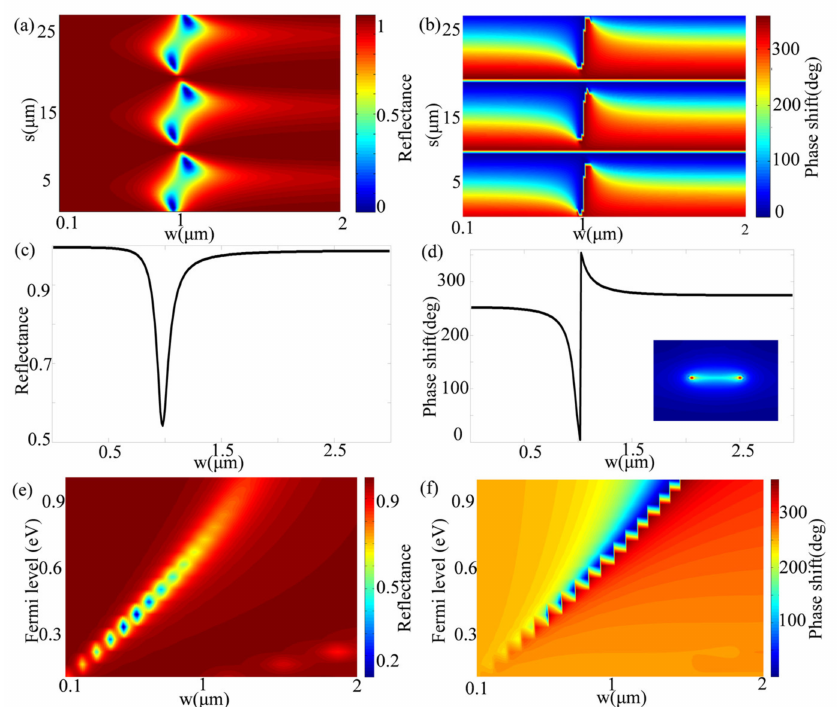
Figure 2. ( a ) Reflectivity and ( b ) phase shift is the function of the graphene ribbon width ( w ) and the dielectric layer thickness (s). ( c ) Reflectivity and ( d ) phase shift vary as the graphene ribbon width ( w ) increasing at a thickness of the dielectric layer (s) as 3 µ m. ( e ) Reflectivity and ( f ) phase shift is the function of the graphene ribbon width ( w ) and Fermi energy level ( E F ). The inset shows the distribution of the electric field at plasmonic resonance when the graphene ribbon width and the dielectric layers are 1.03 µ m and 3 µ m, respectively, at the operating frequency of 12.32